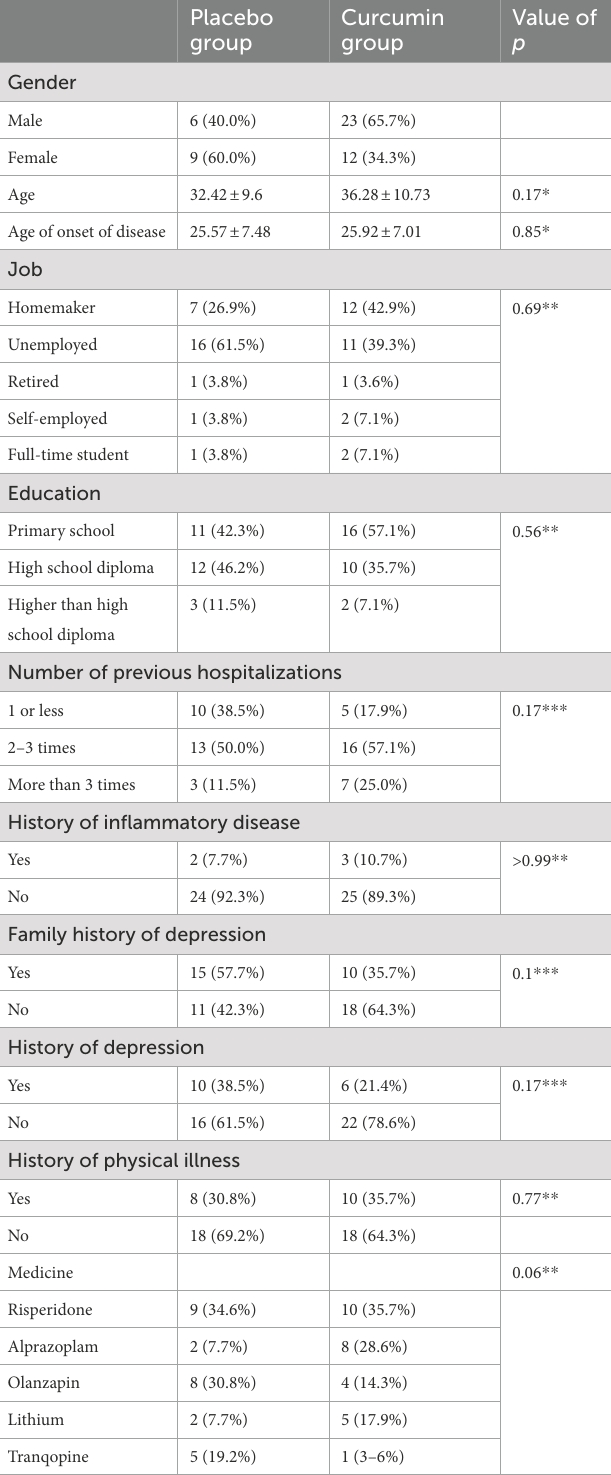
TABLE 1 Demographical information of the studied population. Placebo